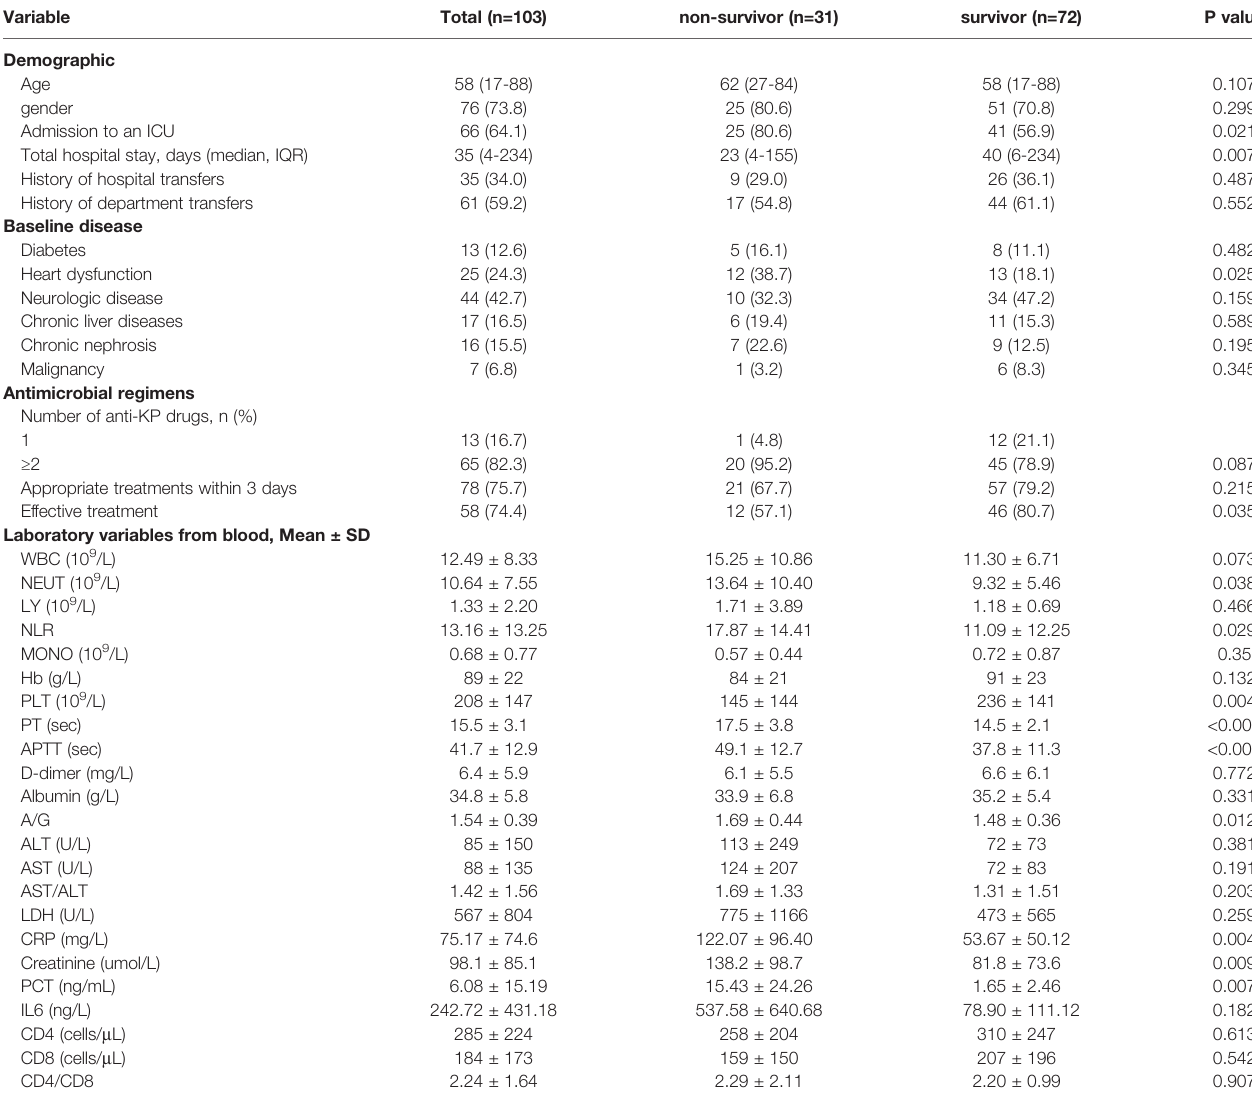
TABLE 2 | Univariate analysis of 30-day mortality of patients with CRKP and CRAB co-infection.